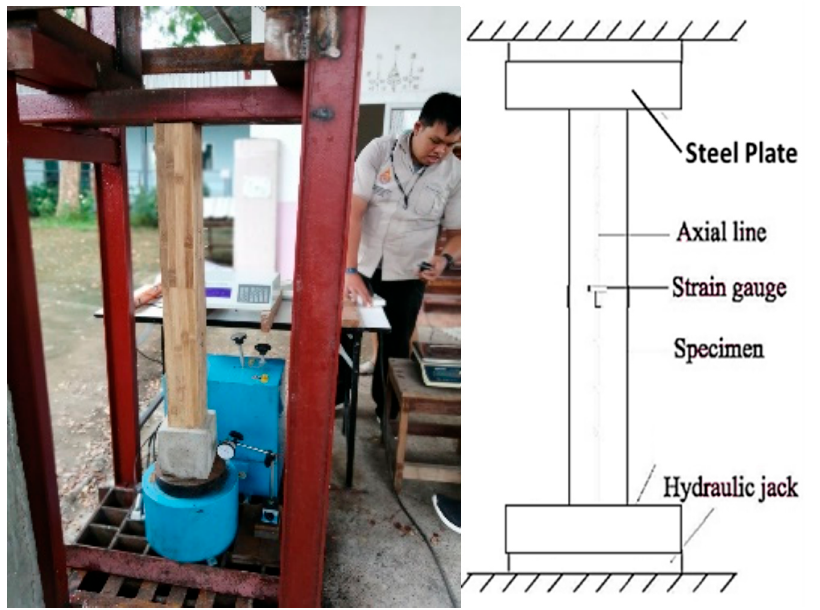
Figure 4. Detail of the test specimens.